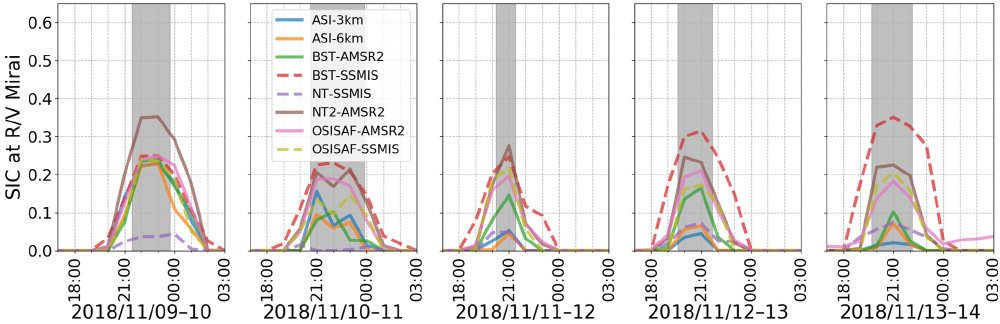
Figure D2. Satellite-retrieved SIC for all products along the R/V Mirai track during Phase 1 between 9 and 13 November 2018. The figure schematics of SIC estimates are as follows: ASI-3km (blue), ASI-6km (orange), BST-AMSR2 (green), BST-SSMIS (red), NT2-AMSR2 (purple), NT-SSMIS (brown), OSISAF-AMSR2 (pink), and OSISAF-SSMIS (olive), and SSMIS and AMSR2 are distinguished by dashed and solid lines, respectively. Grey highlighted times indicate when the vessel was in ice cover based on the ice navigator’s logs.